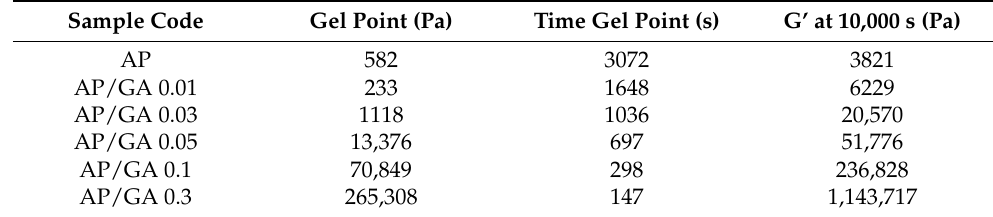
Table 2. Rheological parameters of the AP and AP/GA coatings.